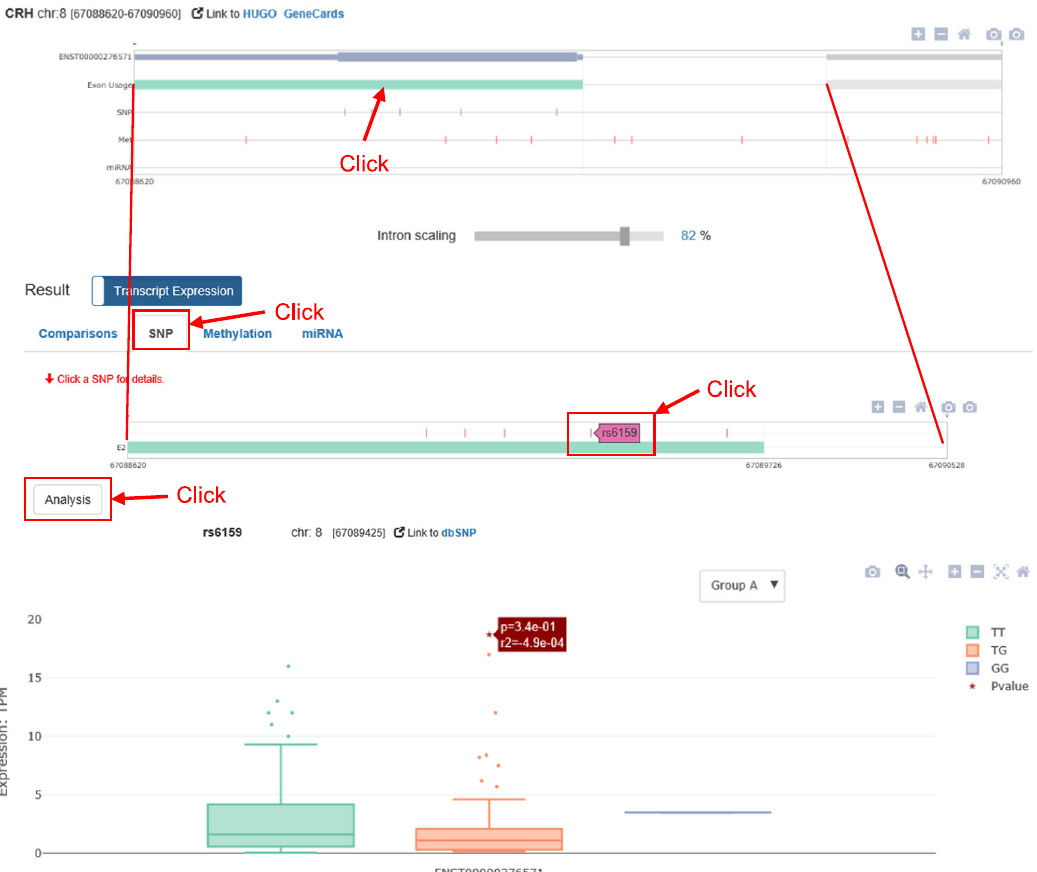
Fig. 5 SNP tab of ADAS-viewer “ Transcript Expression ” analysis results. This example shows an association test of rs6159 with ENST00000276571